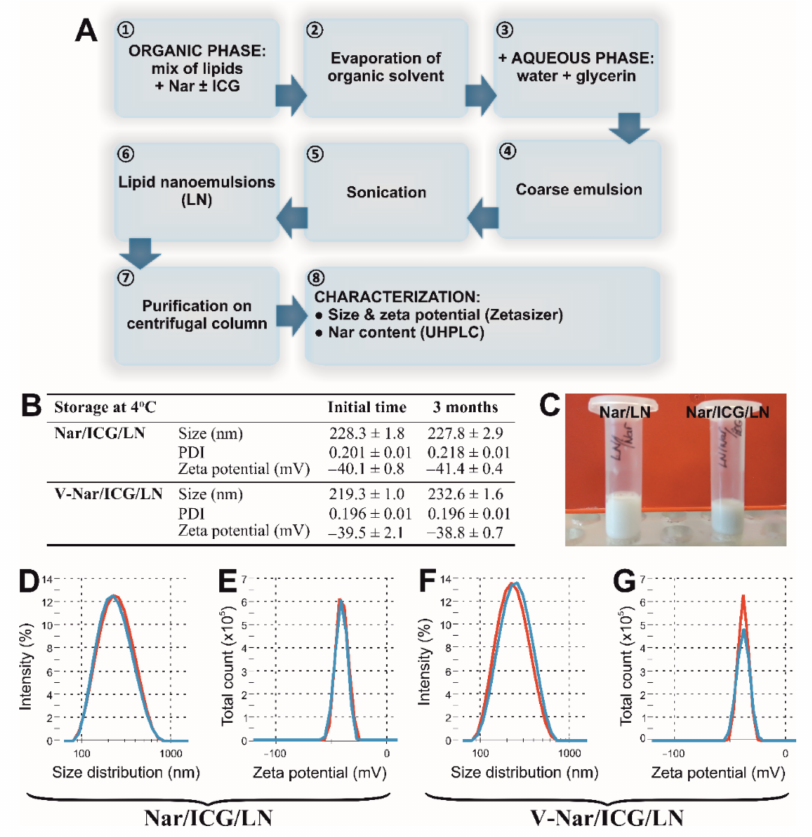
Figure 1. ( A ) Flow chart for the preparation and characterization of non-targeted naringenin-loaded lipid nanoemulsions (LN), either incorporating ICG (for biodistribution studies) or not (for evaluating the anti-inflammatory e ff ect in a mouse model). ( B ) Physico-chemical characterization of lipid nanoemulsions incorporating naringenin and ICG. Summary of sizes, PDIs and zeta potentials for non-targeted (Nar / ICG / LN) and VCAM-1 targeted (V-Nar / ICG / LN) nanoemulsions at the initial time of preparation and after 3-month storage at 4 ◦ C. Standard deviations correspond to independent measurements for at least n = 6. ( C ) Photograph depicting Nar / ICG / LN (right) as compared with Nar / LN (left). ( D , F ) Particle size intensity distribution of non-targeted Nar / ICG / LN ( D ) and targeted V-Nar / ICG / LN (F) nanoemulsions as measured by dynamic light scattering. ( E , G ) Zeta potential distribution of non-targeted ( E ) and targeted ( G ) nanoemulsions measured by electrophoretic light scattering. Red curves correspond to the initial time, and blue curves represent measurements after 3-month storage at 4 ◦